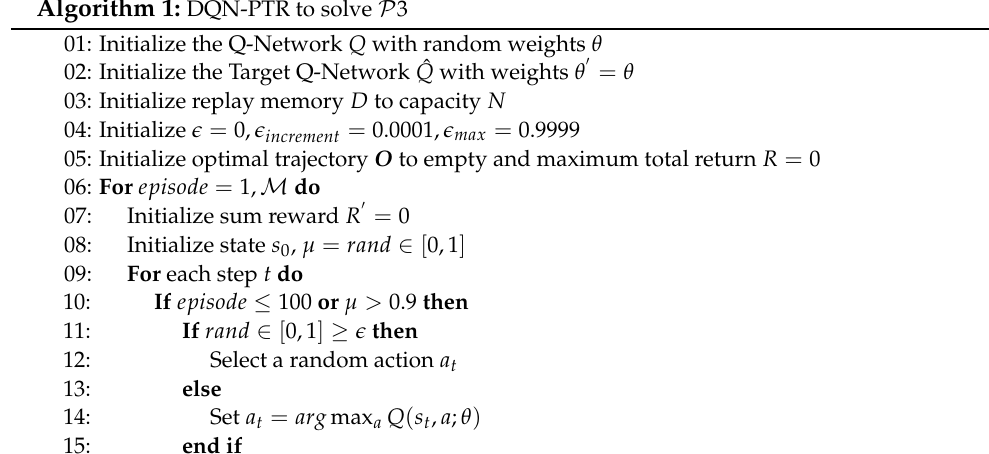
Algorithm 1: DQN-PTR to solve P